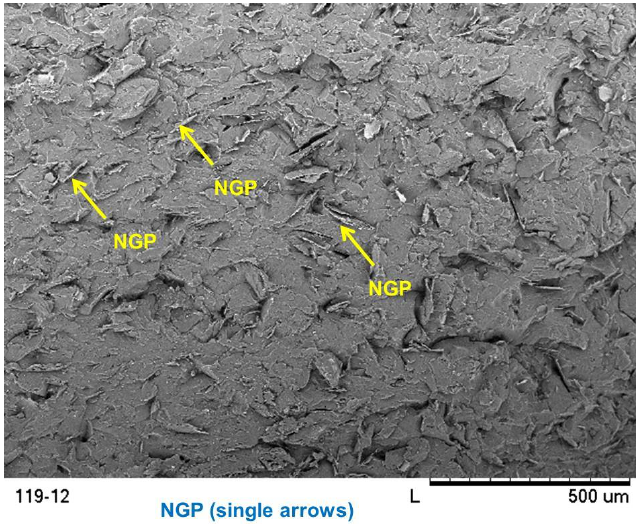
Figure 7. Overview nanocomposite fracture surfaces showing the graphene dispersion.